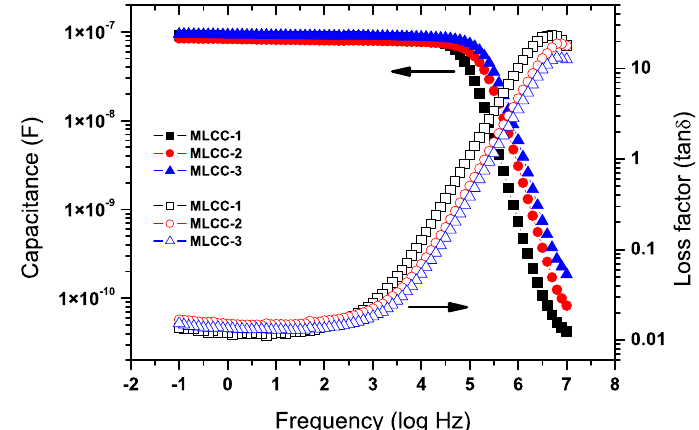
Figure 5. Capacitance and dielectric losses of the three types of MLCCs for this study. Capacitance values for all MLCC types are close to 100 nF.